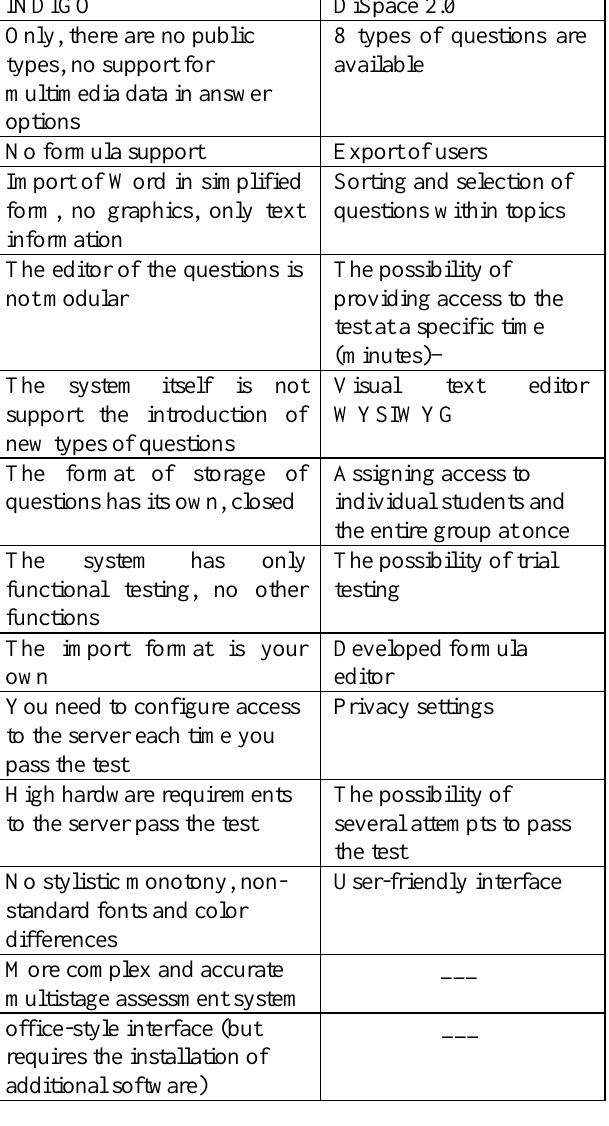
Table 2. Analysis of testing systems INDIGO and DiSpace